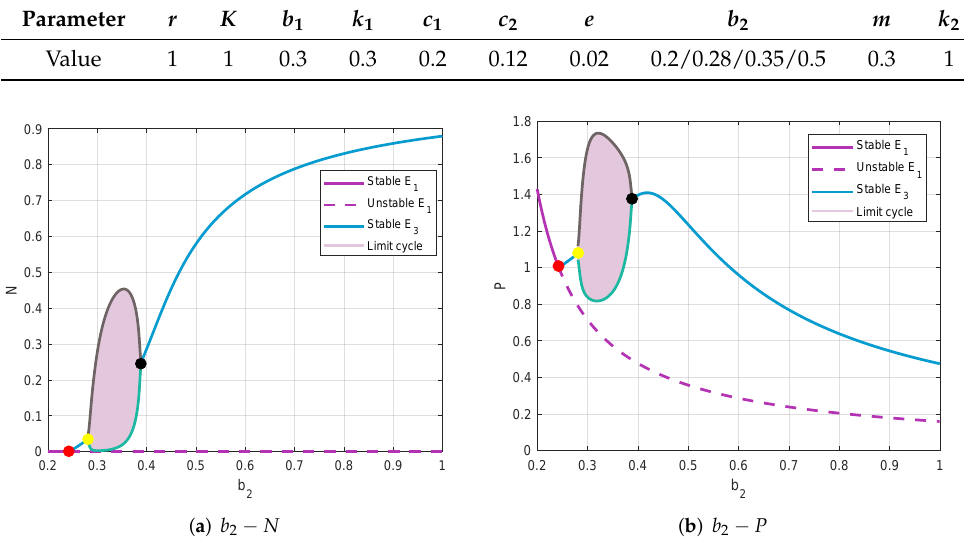
Table 3. Values of parameter to see the impacts of predator cannibalism rate.